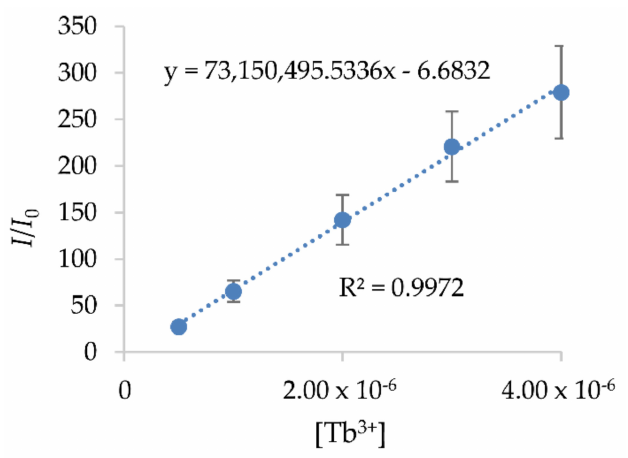
Figure 9. Calibration curves of Tb 3 adsorption from the fluorescence spectrometer.